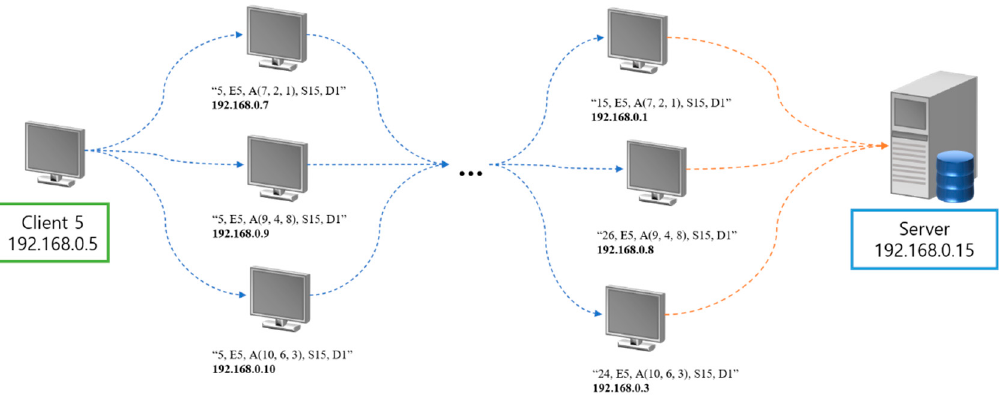
Figure 5. Process through which data are transmitted from clients to the server.